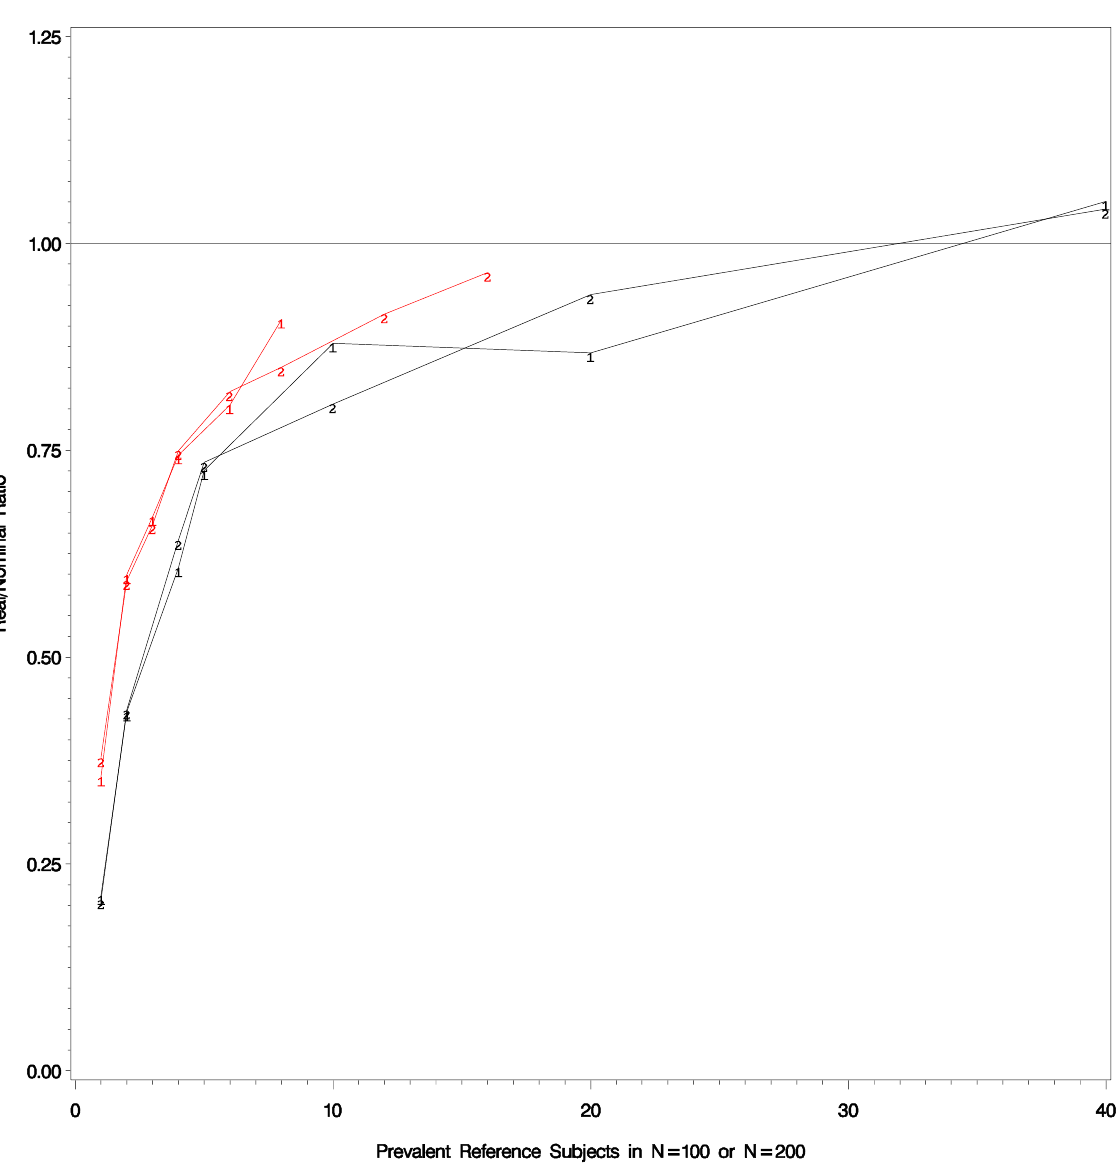
Figure 2. Factors controlling the departure of real and nominal weights. The red curves correspond to a prevalence ratio of 10, and the black curves correspond to a prevalence ratio of 2. For each fixed prevalence ratio, two sample sizes N 0 ~ N 1 ~ 100 (plotting symbol =1) and N 0 ~ N 1 ~ 200 (plotting symbol =2) are shown. For a fixed prevalence ratio and sample size, one can vary the number of positives in class 0 ( C 0 ), and compute the corresponding number of positives in class 1 ( C 1 ). The x-axis is C 0 . One can then compute the nominal and real weights from C 0 , C 1 , N 0 , and N 1 . The primary determinate for departures between the real and nominal weights appears to be the number of positives in the sample (x-axis), and not the total sample size (1 versus 2 plotting symbol). The apparent prevalence ratio (red versus black) appears to play a minor secondary